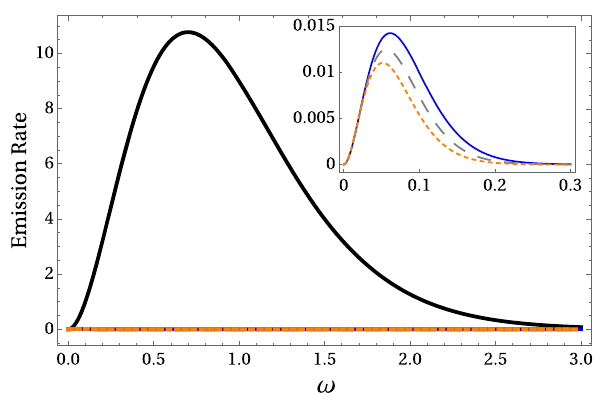
Fig. 3 Emission rate of the rotating polytropic BH for a / M = 0 . 5 and L / M = 7 (solid blue line), L / M = 7 . 5 (dashed gray line) and L / M = 8 (dotted orange line). The solid black line corresponds to the emission of a Kerr